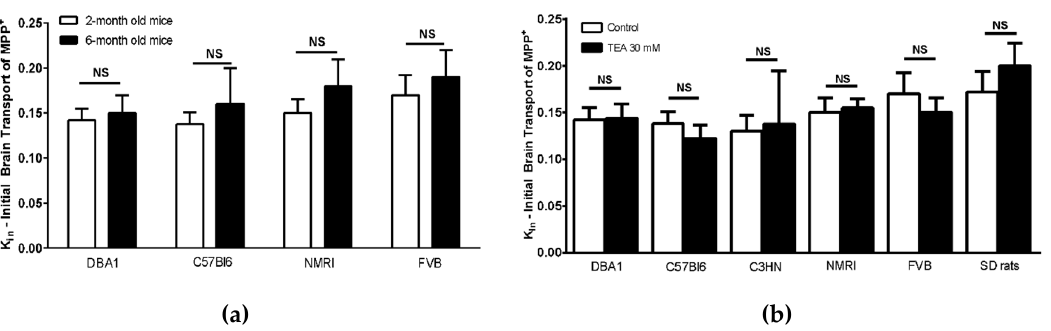
Figure 5. ( a ) Brain transport (Kin; µL s -1 g -1 ) of [ 3 H]-MPP + in 2-month and 6-month-old mice (DBA1, C57Bl/6, NMRI, and FVB) and ( b ) brain transport of [ 3 H]-MPP + with and without co-perfusion of the OCTs inhibitor TEA (30 mM), measured by in situ brain perfusion in 2-month-old mice of different strains and in Sprague Dawley (SD) rats. Results are expressed as mean ± S.D. ( n = 5 animals per group). * p < 0.05 as compared with the appropriate control group. NS: no statistical significance